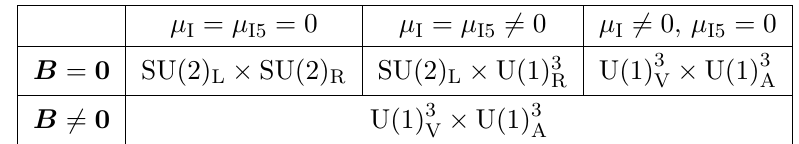
Table 2 . Chiral symmetry of massless two-(cid:13)avor QCD with (cid:22) of B